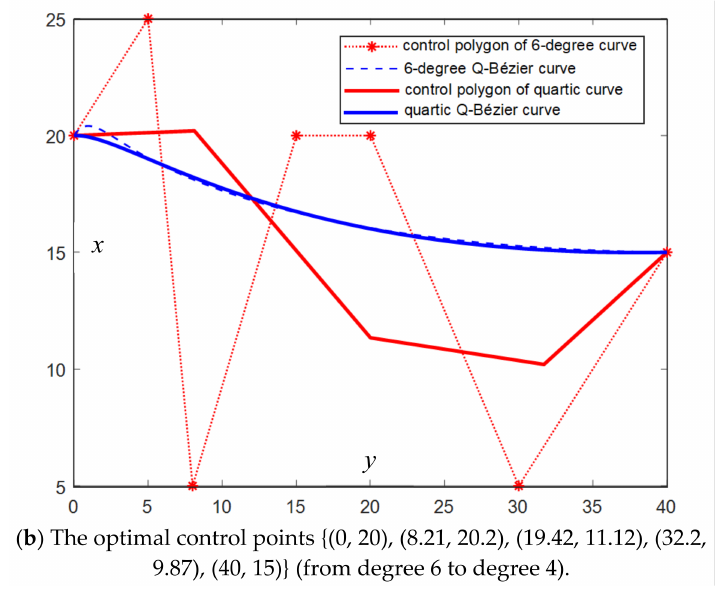
Figure 7. Two-degree reductions of a Q-B é zier curve of degree 5 and degree 6.